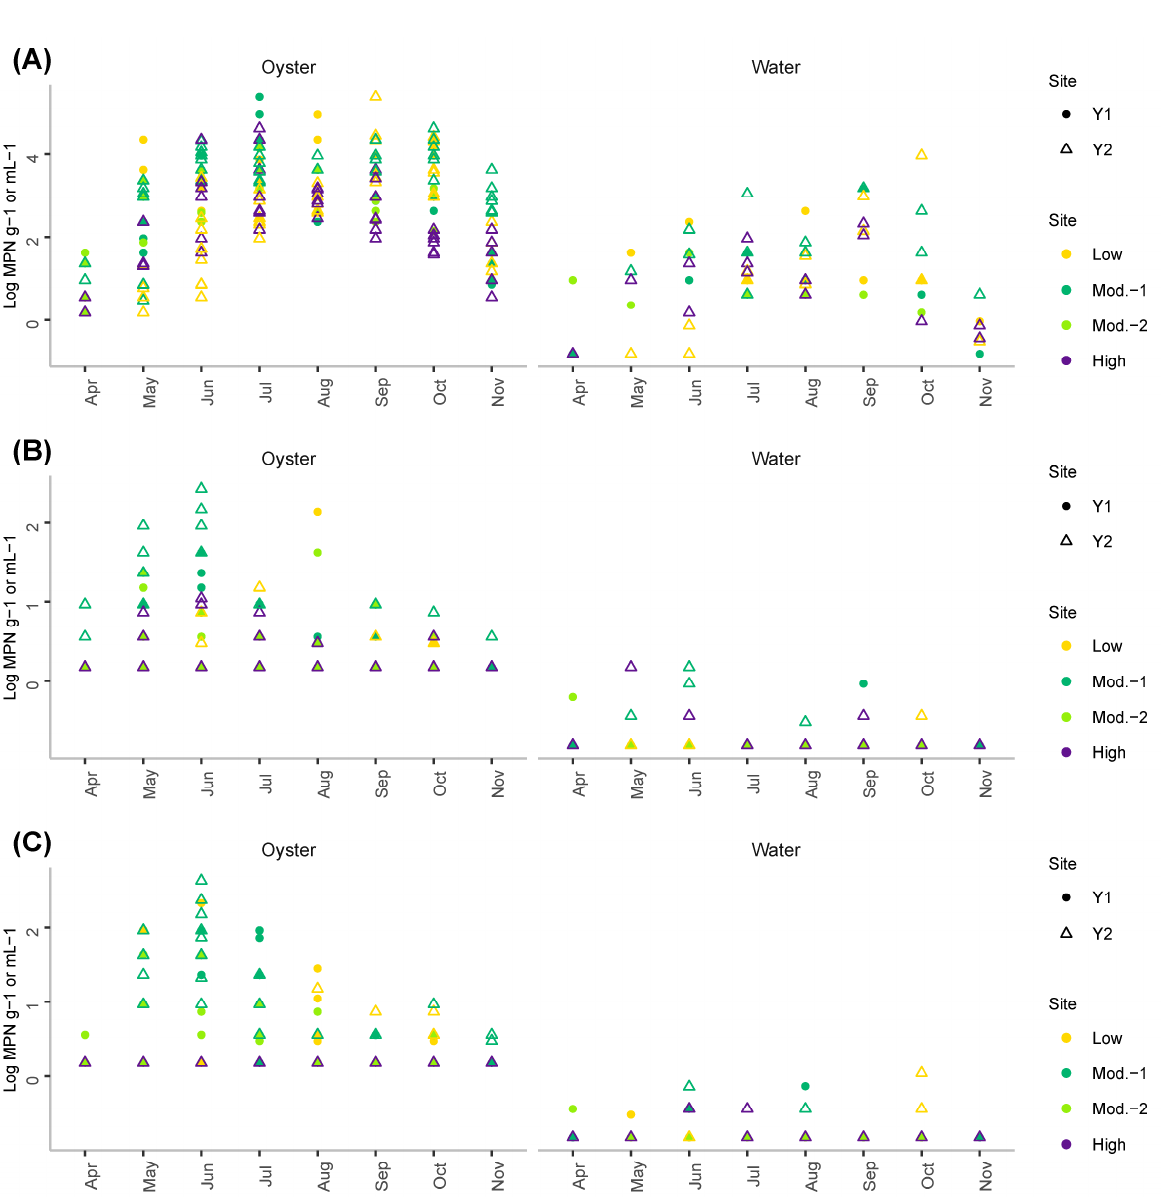
Figure 4. Concentrations of ( A ) total V. parahaemolyticus ( tlh ), ( B ) pathogenic V. parahaemolyticus tdh + and ( C ) pathogenic V. parahaemolyticus trh + measured in oysters ( left panel ) and water samples ( right panel ).